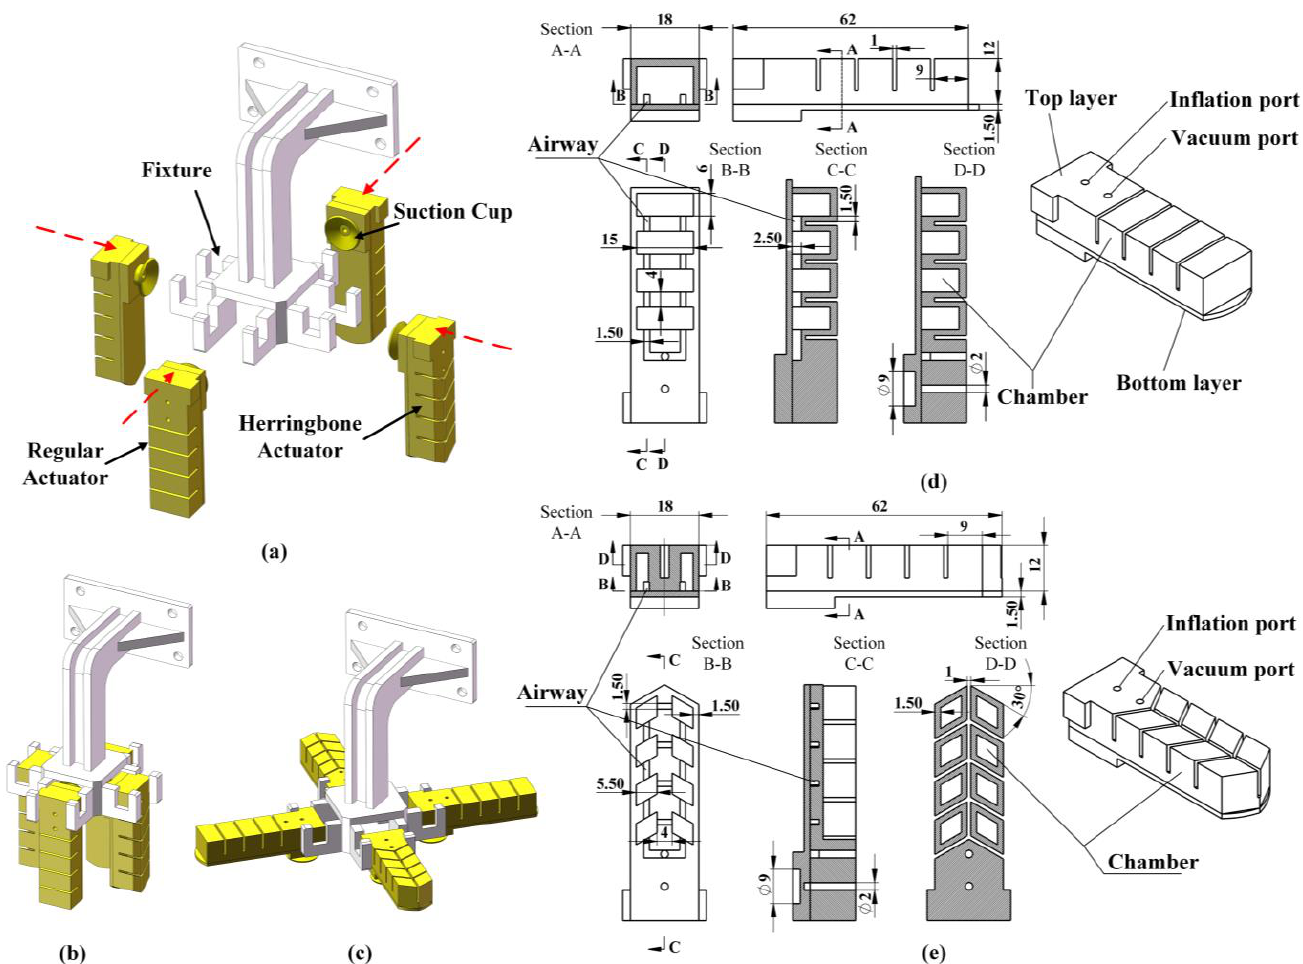
Figure 1. Schematic structures of the modular soft gripper and the actuators. ( a ) Exploded view of the soft gripper. ( b ) Vertical assembly and ( c ) horizontal assembly of the gripper. ( d ) The regular actuator. ( e ) The herringbone actuator.